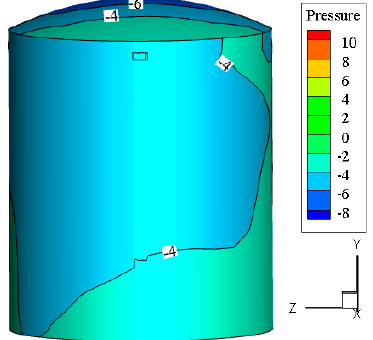
Figure 13. Pressure-cloud diagram for the leeward side of the tank wall (Pa).